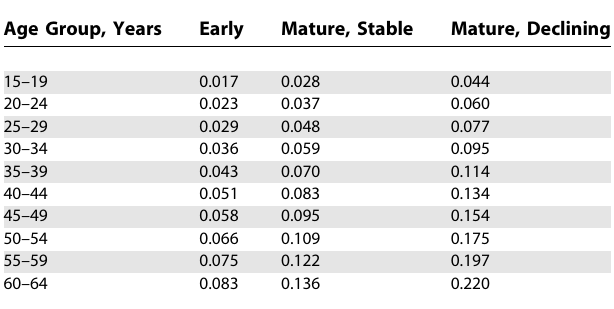
Table 1. Cohort Mortality Rates for HIV-Infected Persons, Tabulated by Age of Cohort at Start of Five-Year Interval and Epidemic Phase